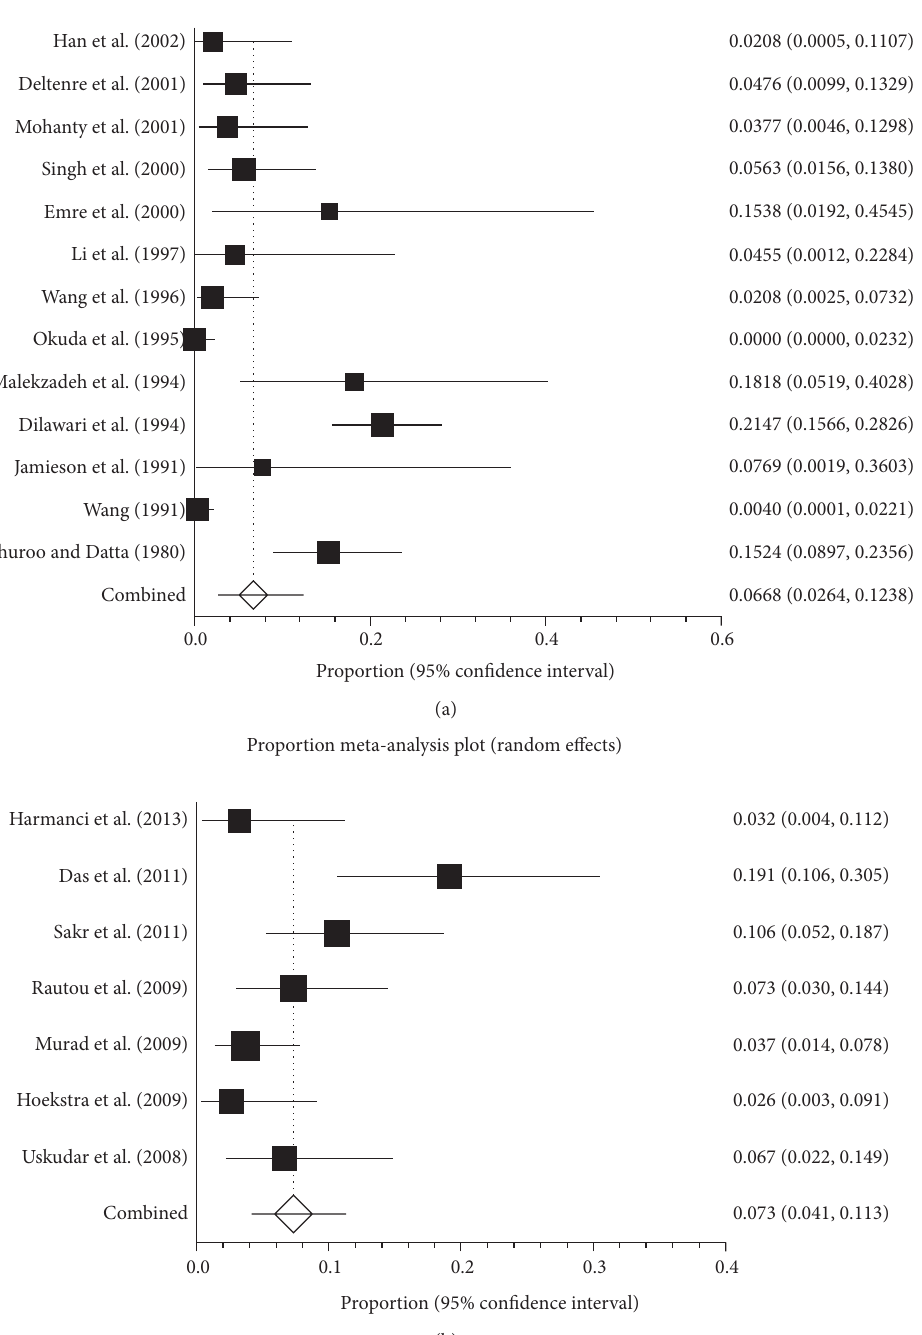
of the relationship between pregnancy and BCS has improved over time. Thus, differences in the prevalence of pregnancy- related BCS might be observed based on publication